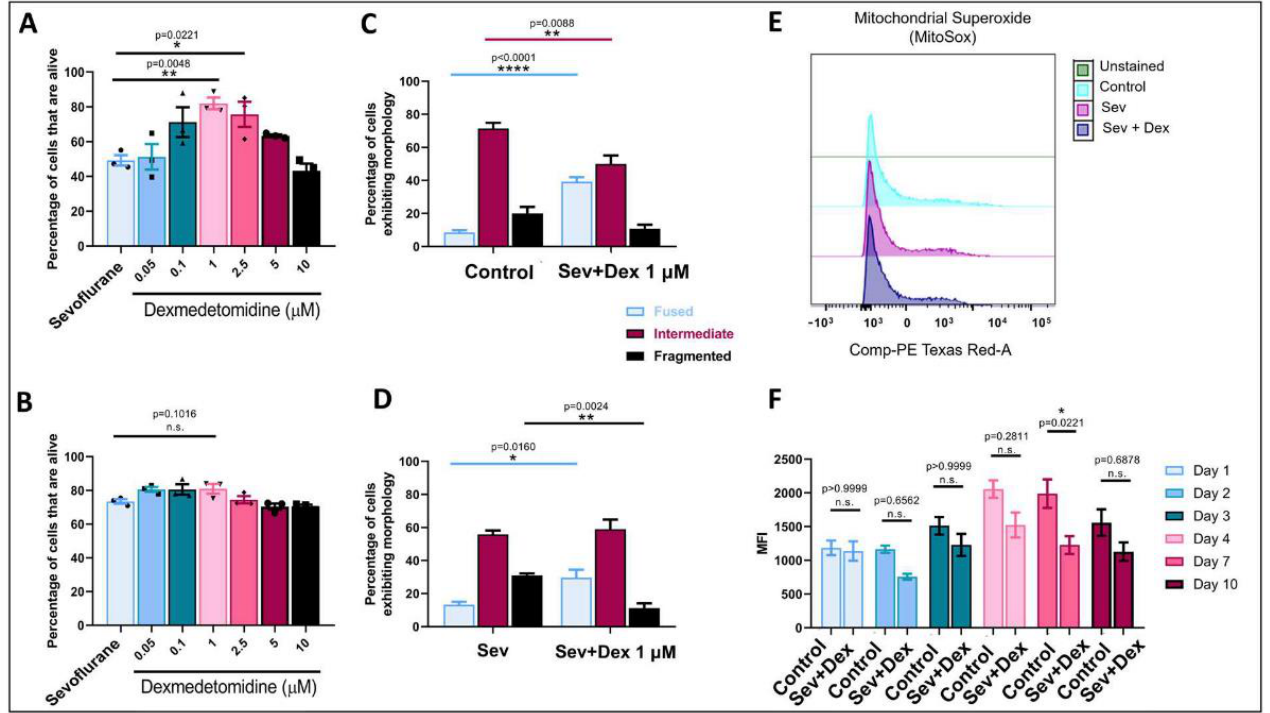
Figure 7. Dexmedetomidine pre-treatment was able to rescue sevoflurane-induced cell death, re- verse mitochondrial fragmentation, and promote a decrease in ROS production. ( A ) Percentage of cells that are alive on day 3 ( B ) and day 7. Concentrations of dexmedetomidine expressed in μM. Bars indicate ± SEM n = 3 dishes per condition, 15 – 20 images per plate. Mitochondrial morphology quantification on day 4 post-anesthetic exposure comparing ( C ) control (untreated cells) versus DEX-pre-treated cells and ( D ) sevoflurane-exposed cells versus Sev + Dex cells. Bars indicate ± SEM n = 7 – 8 dishes per condition, 15 – 20 neurons imaged per plate. ( E ) Representative MFI of mitochon- drial superoxide production by neurons exposed to sevoflurane and DEX-pre-treated cells exposed to sevoflurane compared to controls ( F ) Quantification of MFI of mitochondrial ROS production in Sev + Dex cells on days 1, 2, 3, 4, 7, and 10 compared to untreated cells (control). In ( A ), bars are mean ± SEM F (6,14) = 6.951, ** p = 0.0048 and * p = 0.0221, ( B ) F (6,14) = 5.220, p = 0.0052, ( C ) F (2,39) = 11.43, **** p < 0.0001, ** p = 0.0088 and ( D ) F (2,39) = 14.68, ** p = 0.0024, * p = 0.0160 using